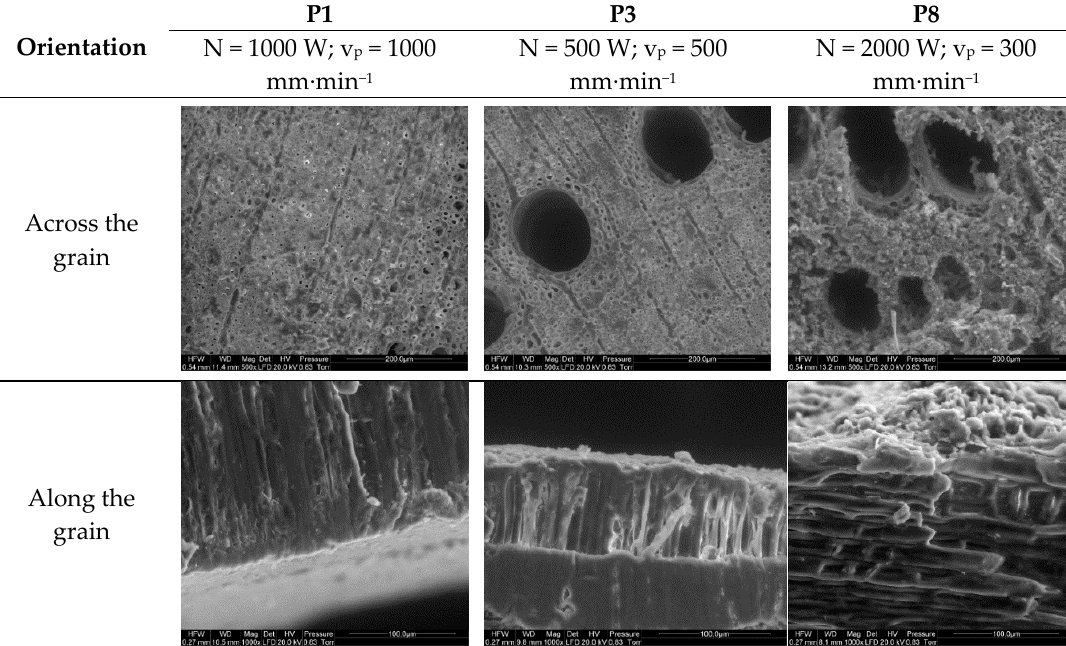
(Figure 6). A reduction in laser power and travel speed to 500 W and 500 mm · min